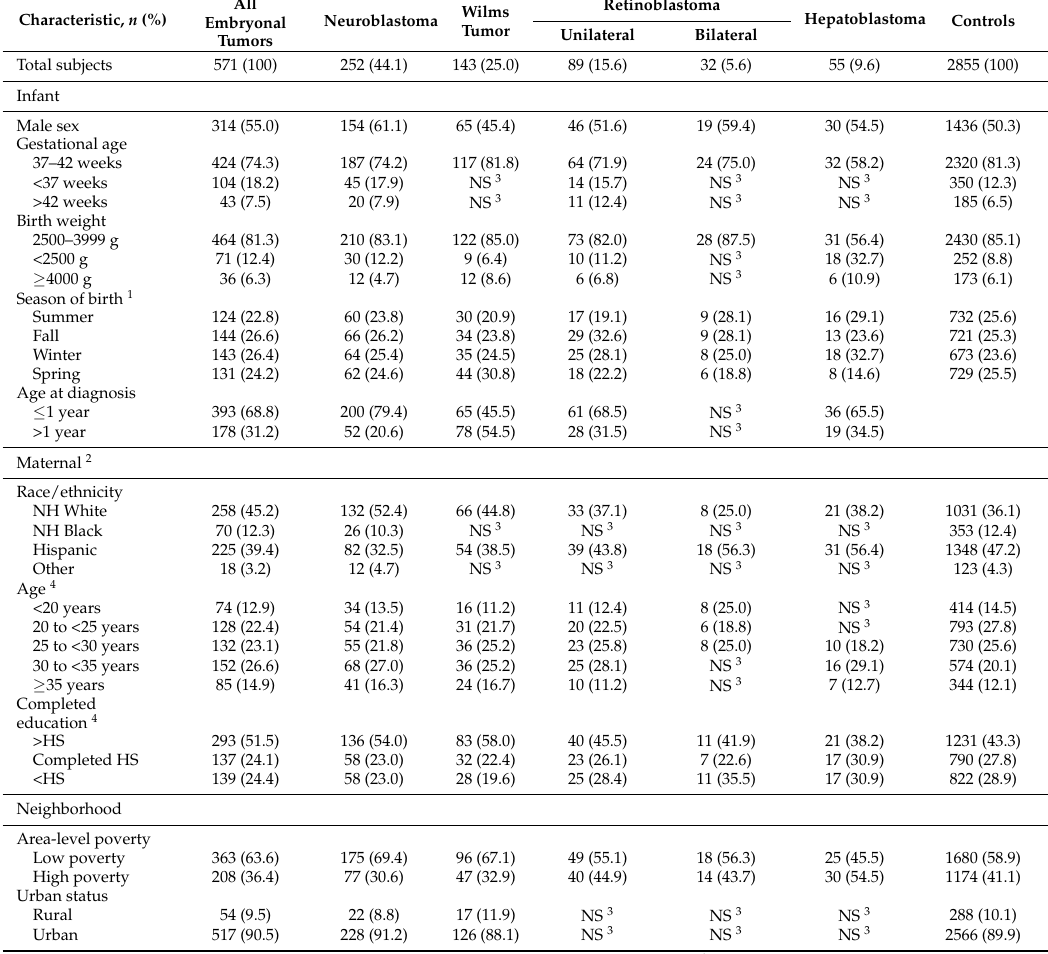
Table 1. Characteristics of pediatric embryonal tumor cases and control subjects in Texas,